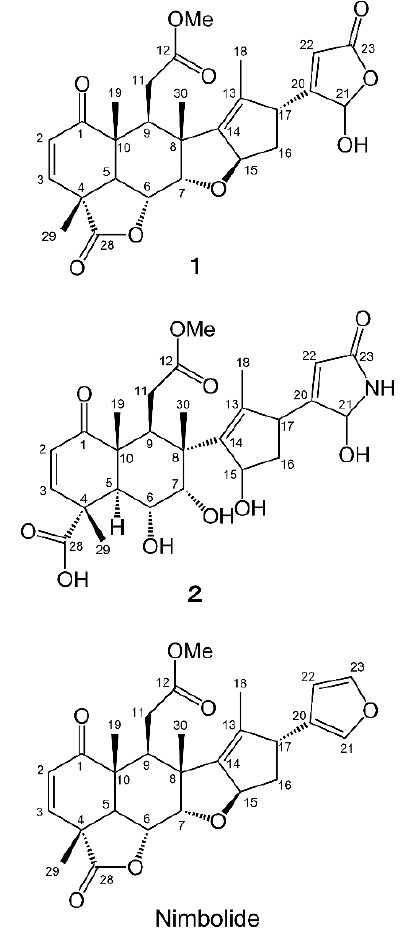
Figure 2. Chemical structures of compounds 1 and 2 .